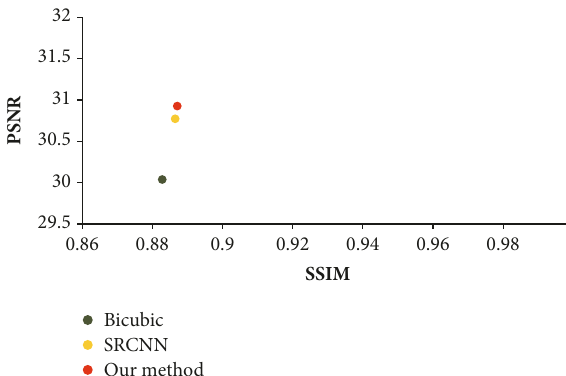
Figure 13: Average value of PSNR and SSIM of actual fault detection by three methods. Red indicates the best performance.